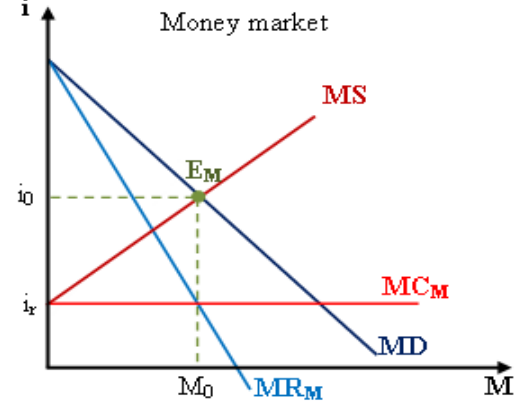
Figure 4. The equilibrium of the money market.